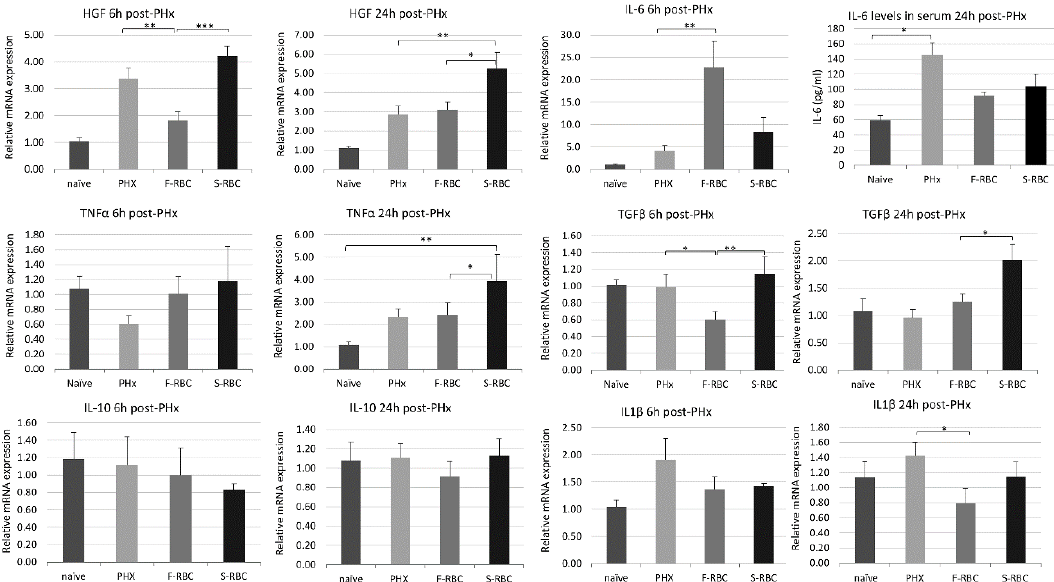
Figure 2. Hepatic cytokine levels after PHx are altered by RBC transfusion. Initiation and termination cytokine levels expressed in livers of the various experimental groups, 6 and 24 h post-PHx. RNA levels were measured by RT-PCR, except than IL6 protein level at 24 h, which was measured by ELISA on serum samples. * p < 0.05, ** p < 0.01, *** p < 0.001.